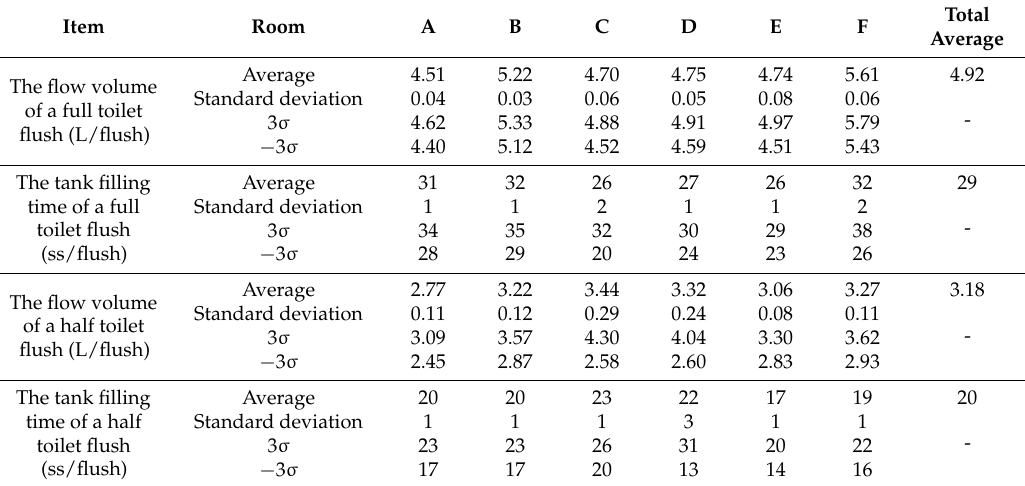
Table 3. The statistical values for full and half toilet